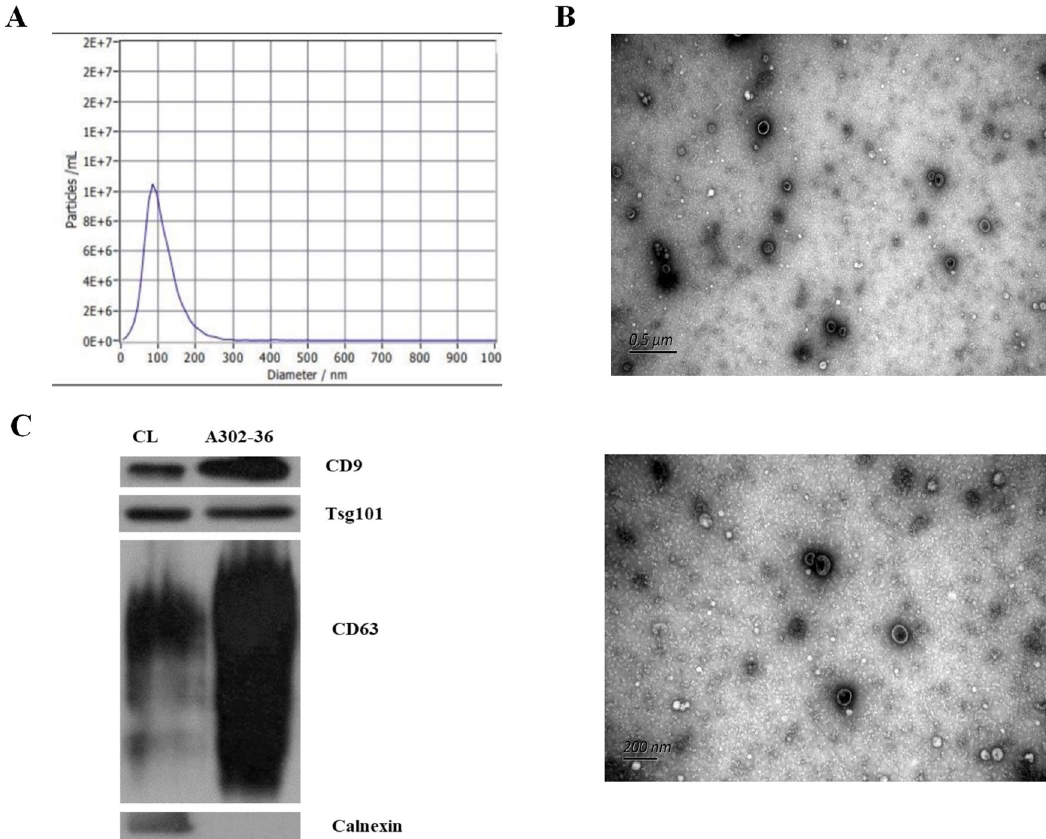
Figure 1. Characterization of plasma-derived exosomes from patients with chronic hepatitis B virus infection (CHB), liver cirrhosis (LC), and hepatocellular carcinoma (HCC) and healthy controls (HCs). The size and morphological distribution of exosomes are shown, and were obtained using nanoparticle tracking analysis (NTA) ( A ) and transmission electron microscopy (TEM) ( B ). The samples were positive for the exosome markers CD9, TSG101, and CD63 and negative for calnexin ( C